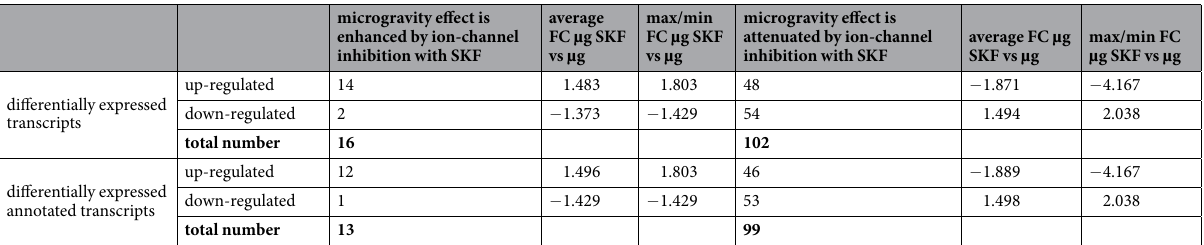
Table 7. Numbers of transcripts that are differentially expressed in response to altered gravitational conditions in an SKF-96365-sensitive manner in the TEXUS-49 suborbital ballistic rocket campaign. Groups comprise transcripts that are 1.) microgravity-sensitive, BL-controlled, 2.) differentially expressed in the comparison µ g SKF vs µ g either in the same direction (enhancement) or in the opposite direction (attenuation), and 3.) not differentially expressed in the comparison H/W 1 g GC SKF vs H/W 1 g GC (exclusion of transcripts that are sensitive to SKF). Differential expression is defined as t-test p-value < 0.05; fold change (FC) ≤− 1.3 or ≥+ 1.3. FCs are ratios between the averages of linear expression values. If the ratio is < 1, FC is calculated as the negative reciprocal of the